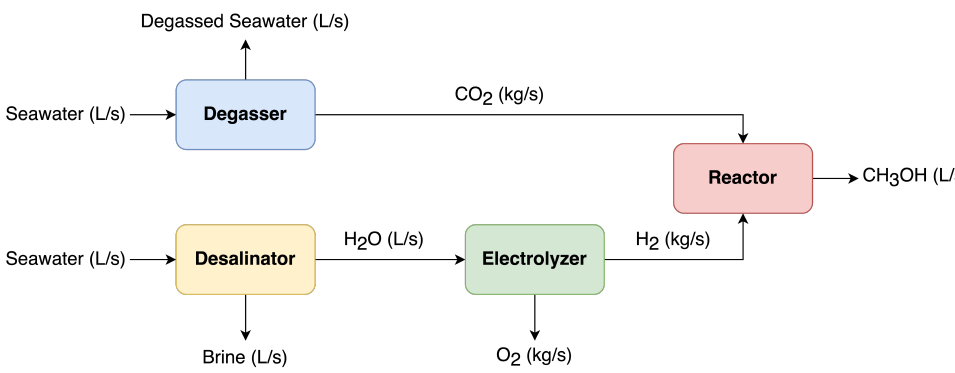
Figure 5. Layout of a methanol island simulated by pyseafuel . Two arms are fed seawater, one through the degasser to extract CO 2 and one through the desalinator and electrolyzer to produce H 2 . The CO 2 and H 2 is then combined in the reactor to produce CH 3 OH, methanol. Waste brine and O 2 are produced as part of the